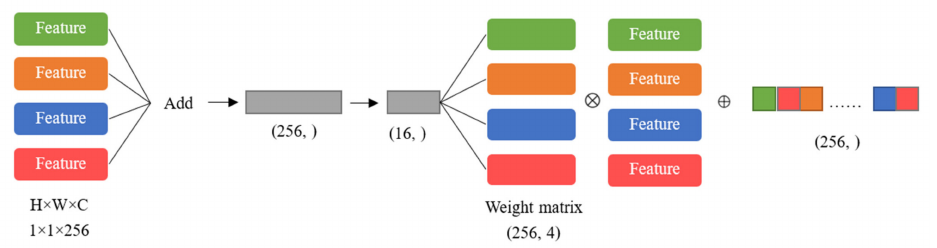
Figure 10. Structure of SK-like adaptive feature fusion